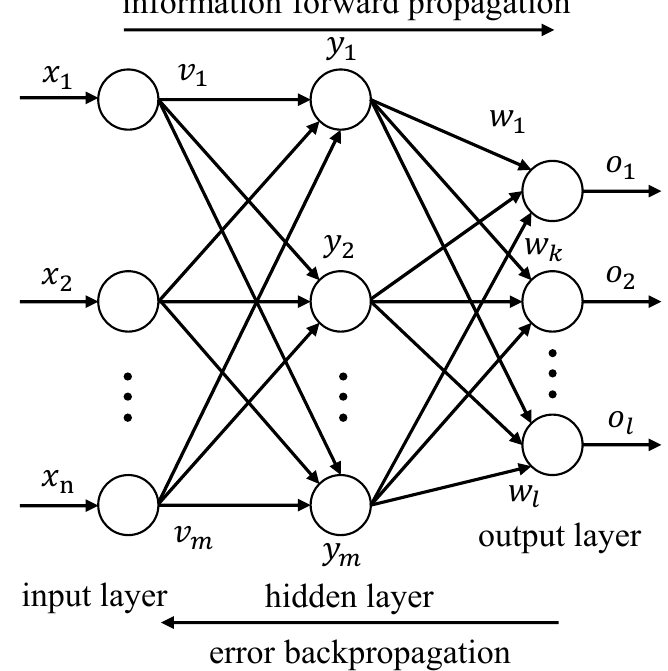
Figure 1. Schematic diagram of a typical BP neural network.